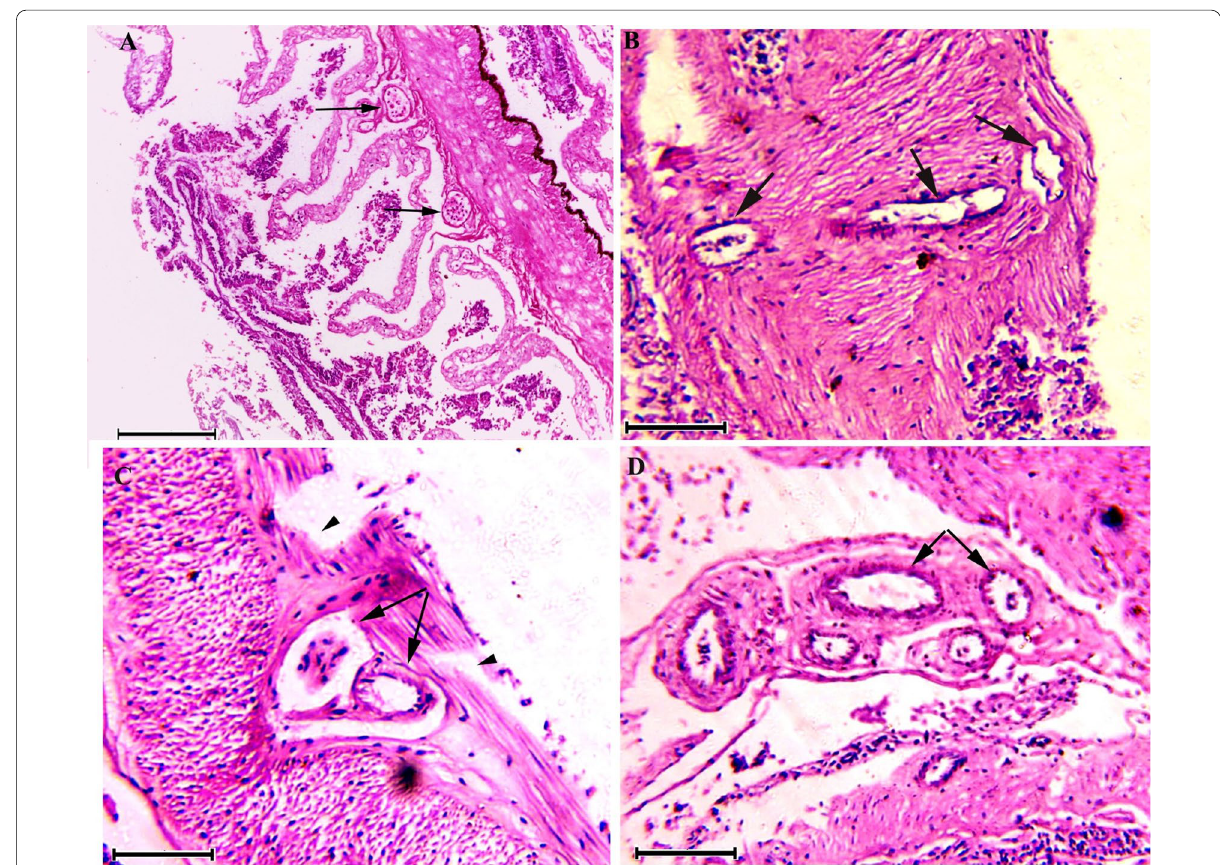
Fig. 2 Cross sections of intestine of C. ocellatus naturally infected with T. chalcidiae showing: a Parasites penetrate along different intestinal layers. b Embedded worms which displaced the muscle fibers c Disintegration and erosion of muscularis and serosa layers with severe lymphocyte infiltration, d Fibrosis in connective tissue, degeneration and atrophy of villi. Arrowhead: erosion and disintegration, Arrow: burrowing of the parasites, scale bars 200 =